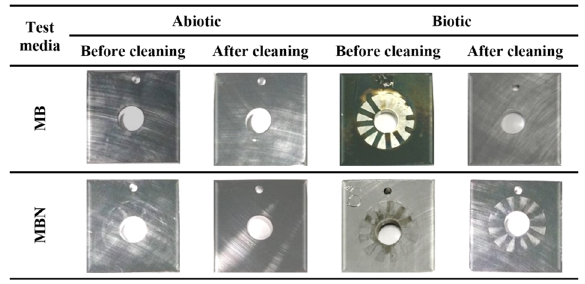
Fig. 1 Photos of creviced coupons taken at the end of the test. Photos of 304 stainless steel coupons (25 × 25 mm) recovered from different test media after 32 days of simple immersion testing under abiotic and biotic conditions at 30